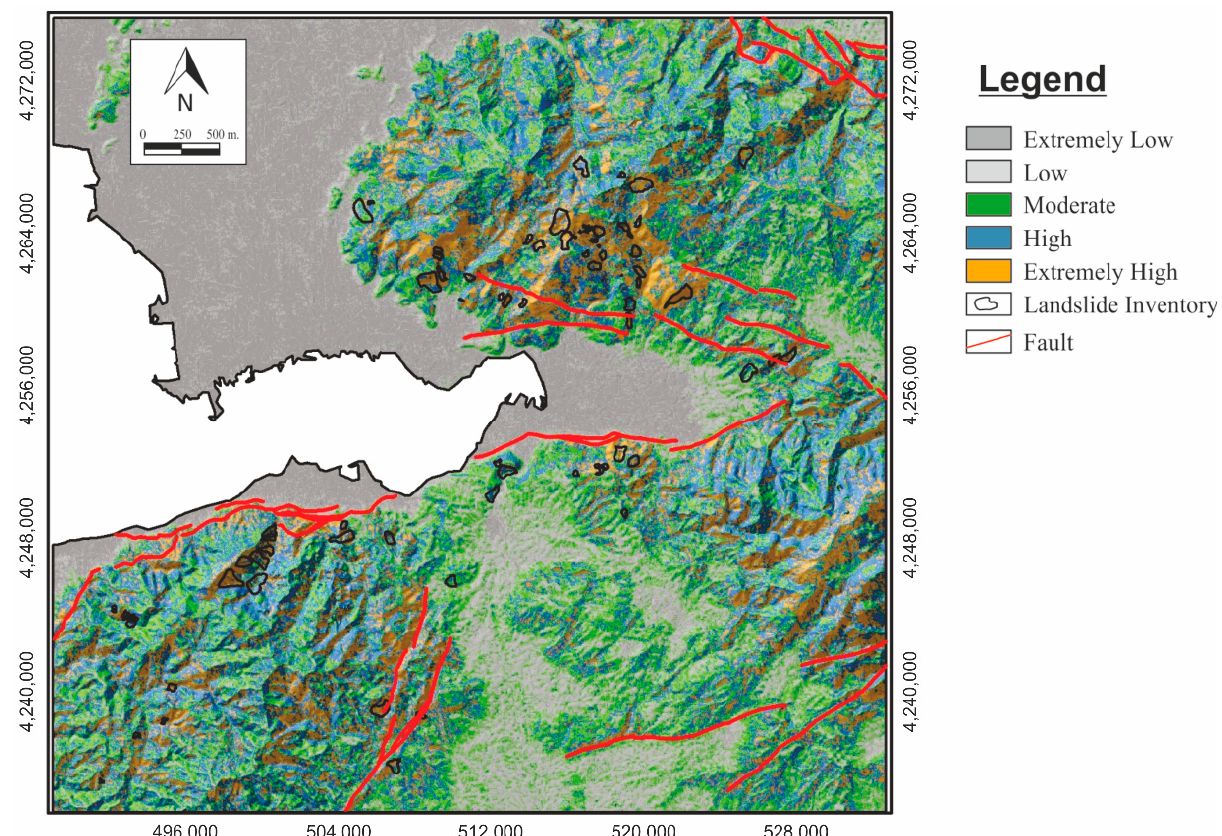
Figure 9. Landslide susceptibility map prepared with the FR method.